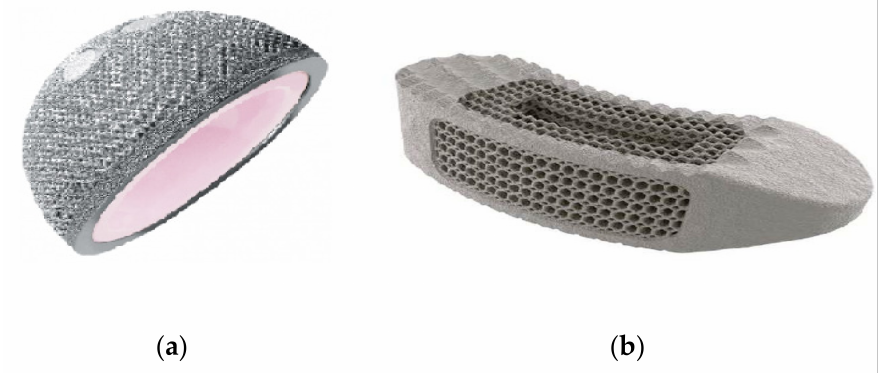
Figure 6. Dental and Medical additive manufactured components: ( a ) titanium-alloy orthopedic device [4], and ( b ) porous titanium spinal implant